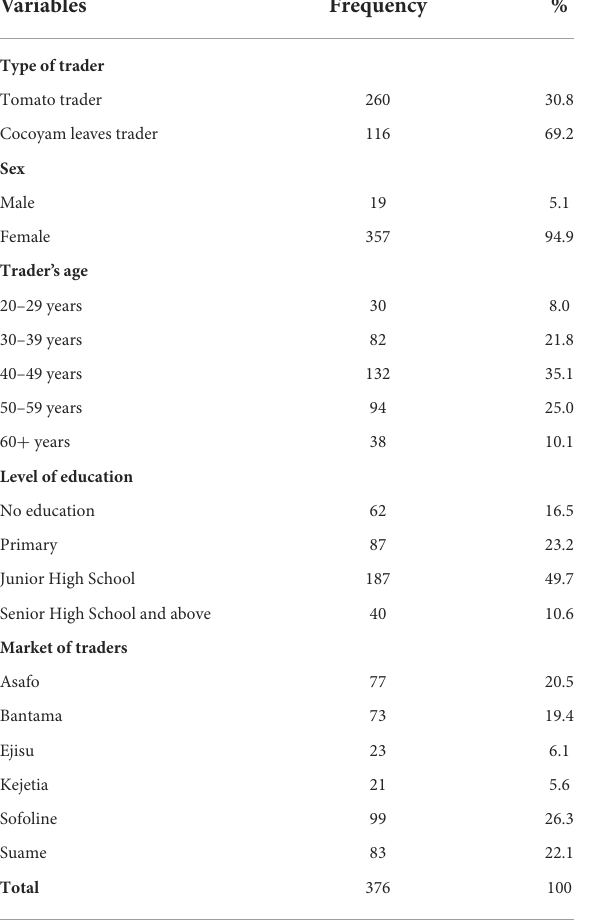
TABLE 2 Background characteristics of respondents. TABLE 3 Business information of tomatoes and cocoyam leaves traders at six markets in